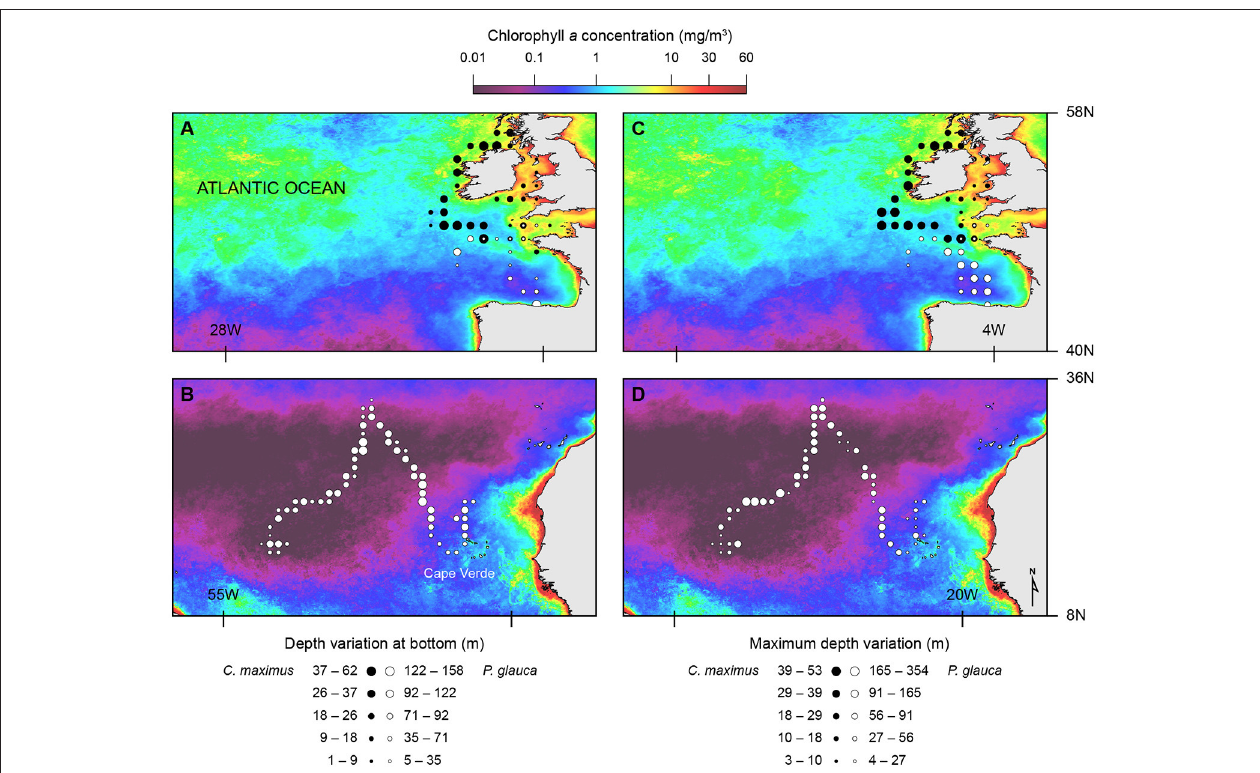
FIGURE 4 | Spatial distribution for two dive parameters overlaid on chlorophyll a mean concentration (2001-2011). Depth variation at bottom phase of U-shaped dives (A,B) and maximum depth variation of V-shaped dives (C,D) for basking (black circles) and blue (white circles)